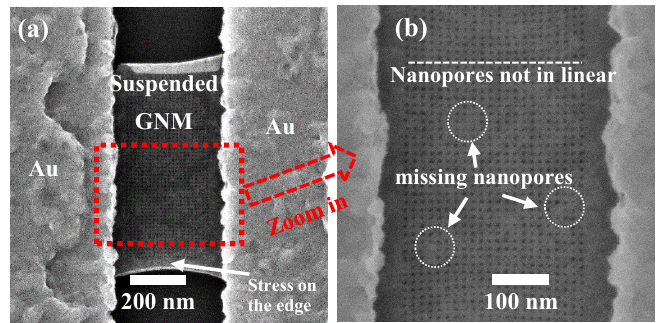
Figure 3. ( a ) HIB secondary electron microscopy image of typical suspended GNM devices. ( b ) 6 nm diameter nanopores and missing nanopores by zooming in at (a).